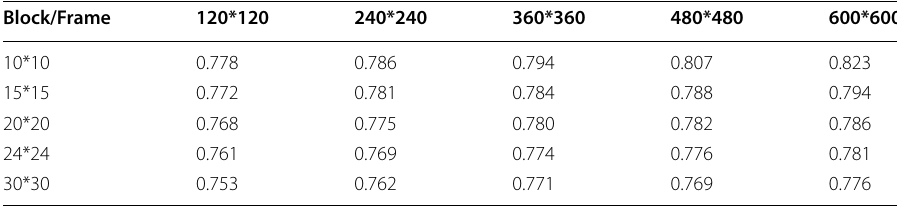
Table 3 F1‑Score performance of S ∗ using UCF50 dataset Block/Frame